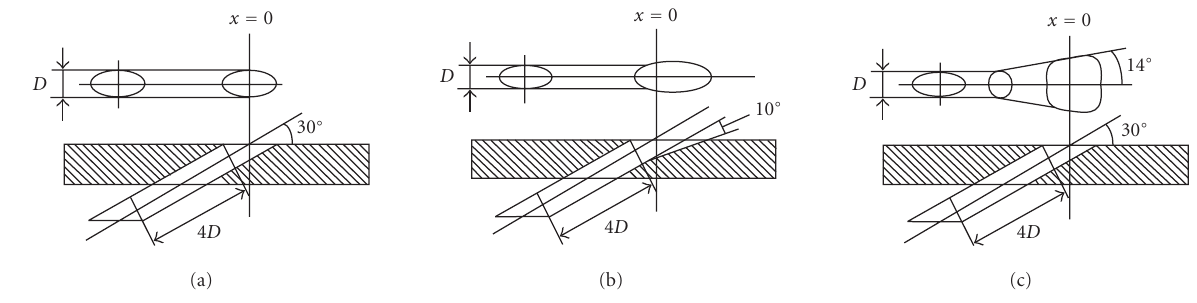
Figure 2: Illustration of the hole configurations: (a) cylindrical hole, (b) di ff user hole, and (c) fanshaped hole.